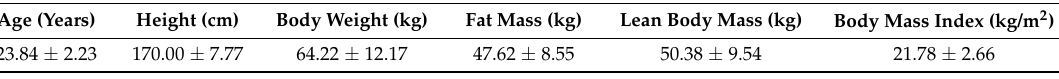
Table 8. Characteristics of subjects included in the D-allulose gastrointestinal tolerance test ( n = 19). Age (Years)